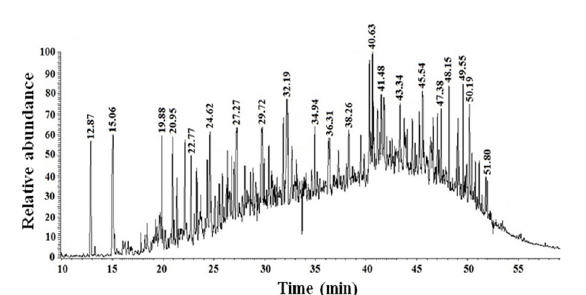
Fig. 11. GC/MS analysis of dichloromethane soluble